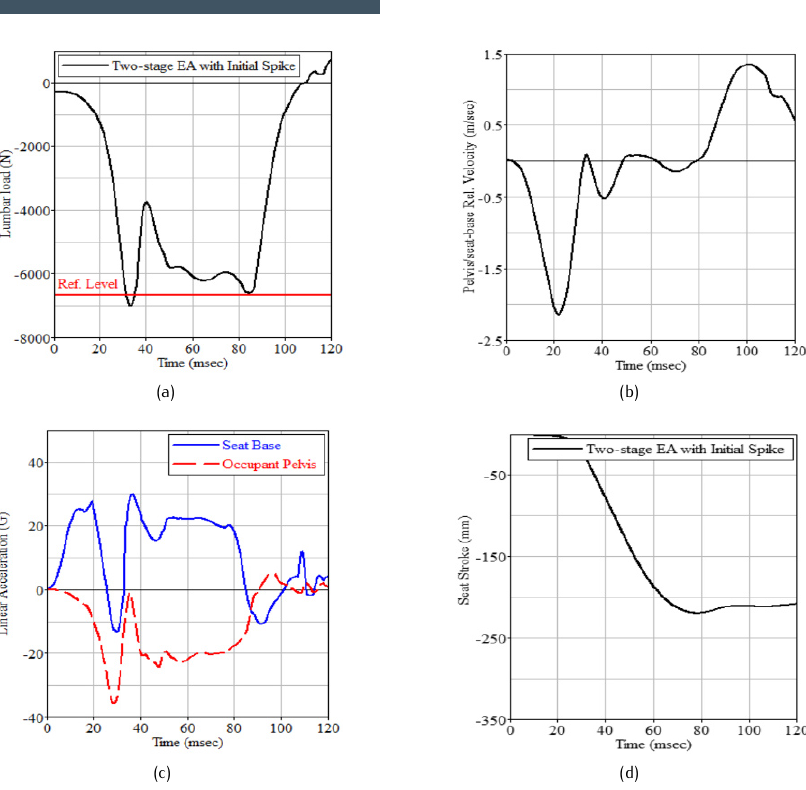
Figure 15. Occupantlumbarload, seat-baseacceleration, seat/occupantrelativevelocity, andseatstroking curve for a two-stage load limiter with initial